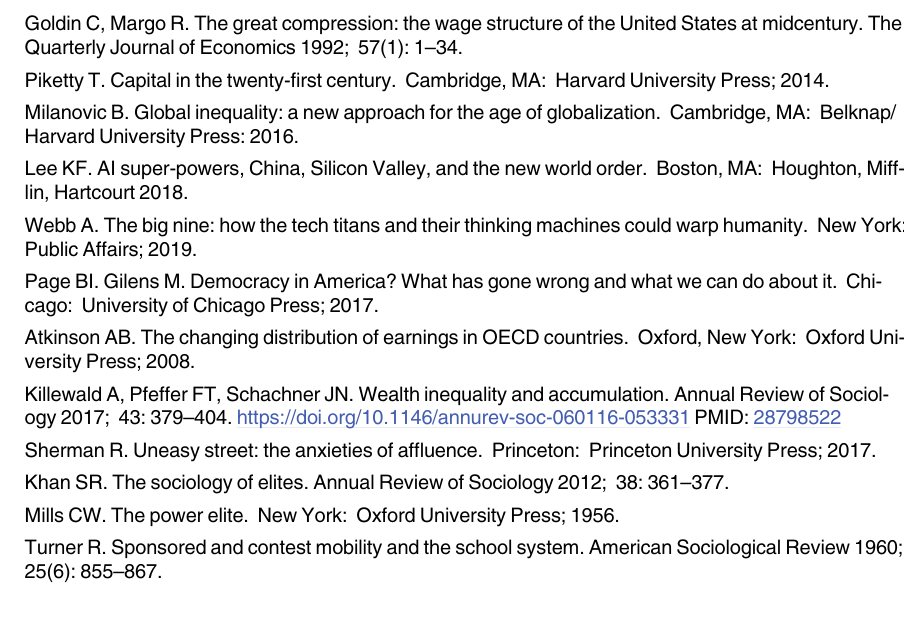
S1 Table. Logistic regression on